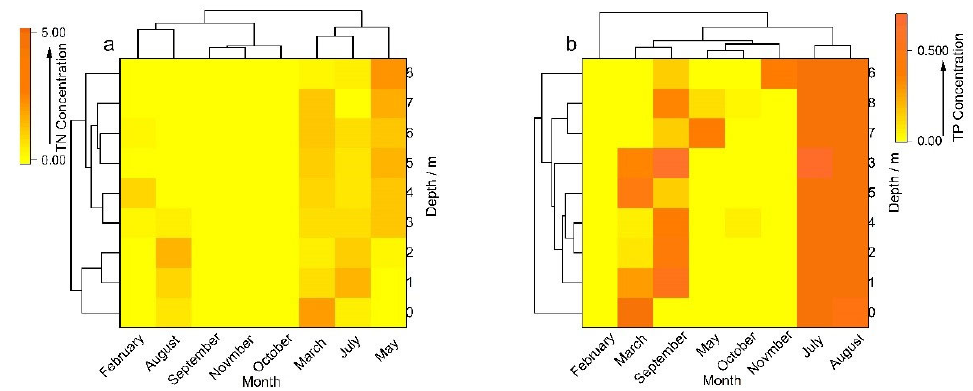
Figure 11. Heatmap showing the temporal and spatial distribution patterns of TN and TP in Lake Xingyun. ( a ) TN. ( b ) TP.